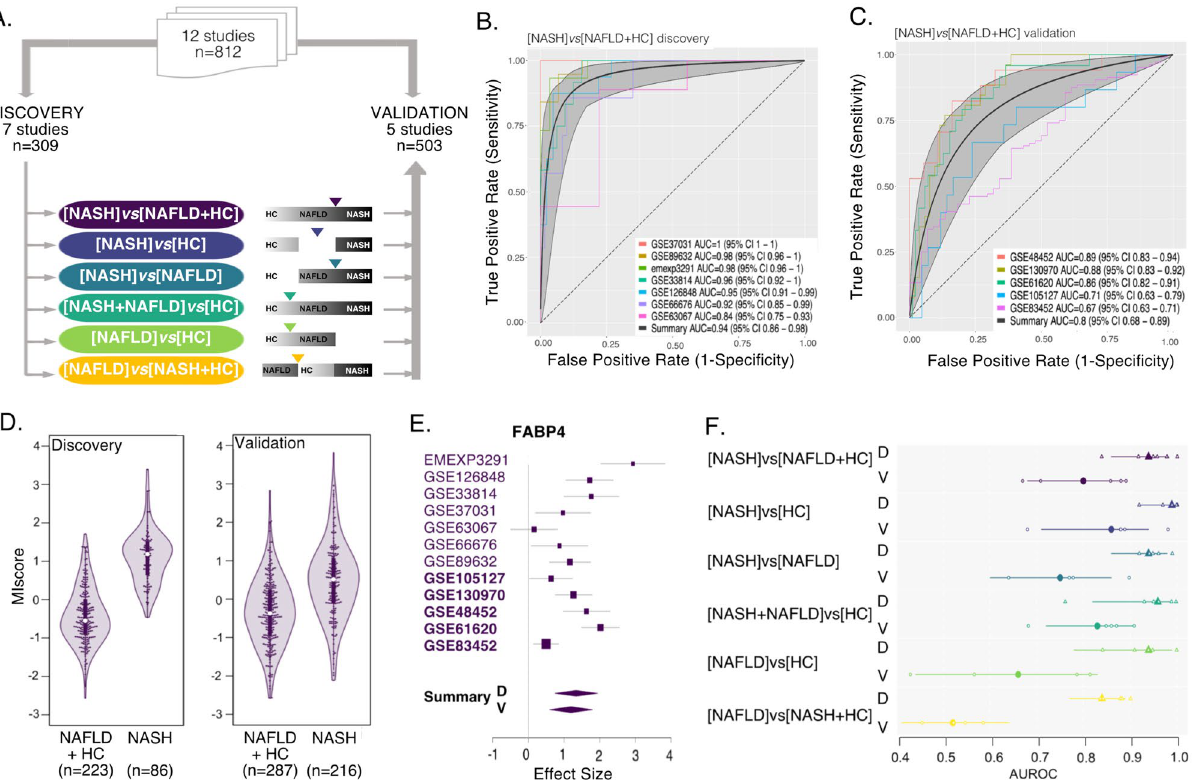
Figure 1. 130-mRNA score robustly distinguishes NASH from NAFLD or HC. ( A ) Study design overview. ( B,C ) ROC curves for [NASH] vs [NAFLD + HC] signature in ( B ) 7 discovery datasets and ( C ) 5 independent validation datasets. ROCs for individual studies are shown in color, summary ROC is shown in black with 95% confidence interval. ( D ) Violin plot of the [NASH]vs[NAFLD + HC] 130-mRNA score in discovery and validation in each group, n indicates number of samples in each class. ( E ) FABP4 effects sizes across datasets, studies in bold are validation. ( F ) Performance (AUROCs) of all six possible signatures. Summary ROC performance and 95% CI are shown in solid symbol and line, smaller empty symbols show performance in individual studies. Triangles indicate discovery, and circles validation. Color coding same as in ( A ).